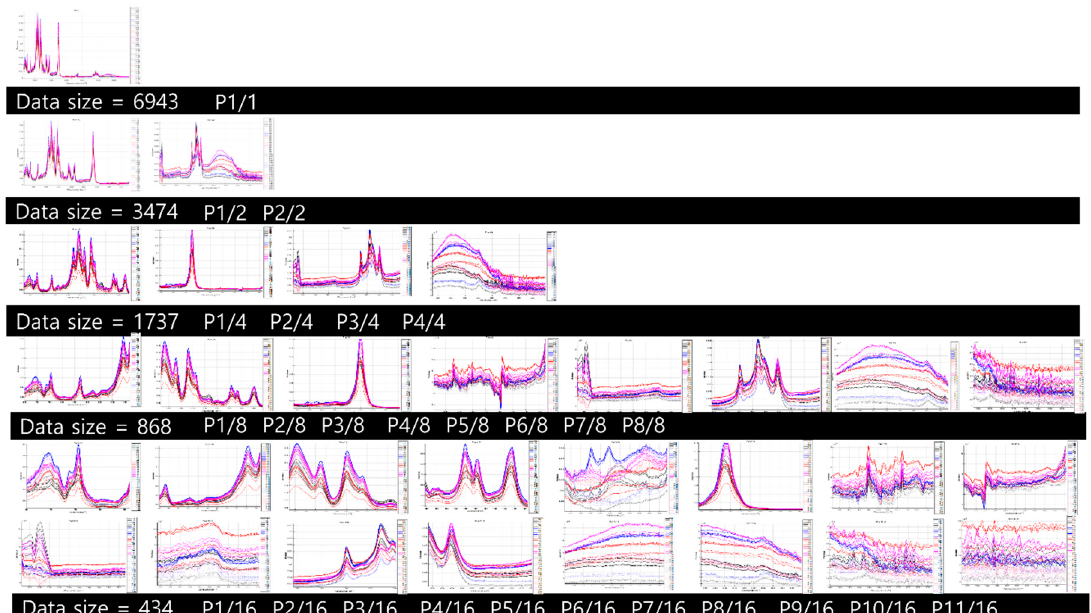
Figure 7. The number of divisions for FTIR spectra as input datasets for ANNs.